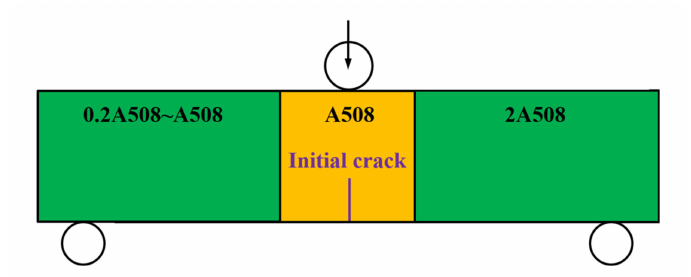
Figure 3. The structure and materials of the second crack-branching model.